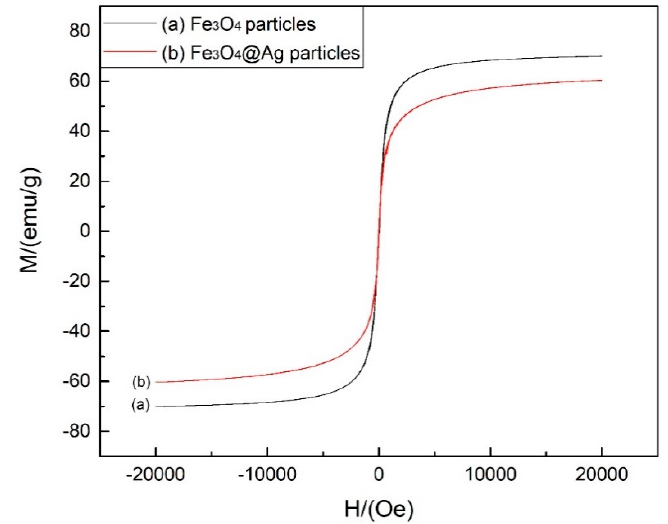
Figure 5. Hysteresis loops of ( a ) Fe 3 O 4 particles and ( b ) Fe 3 O 4 @Ag particles.